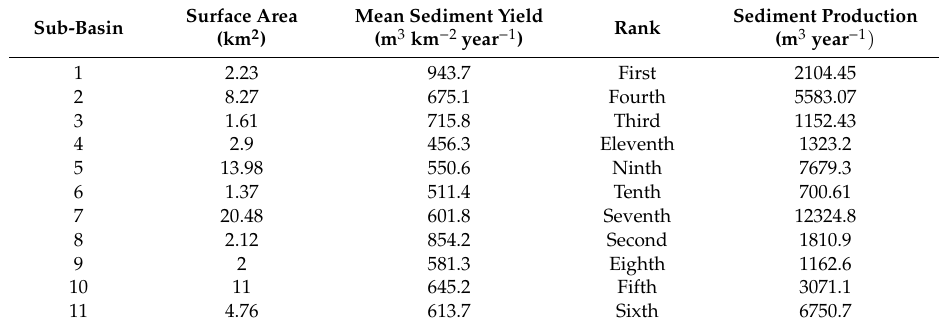
Table 8. Surface area, mean sediment yield, and sediment production at each sub-basin of the study area.